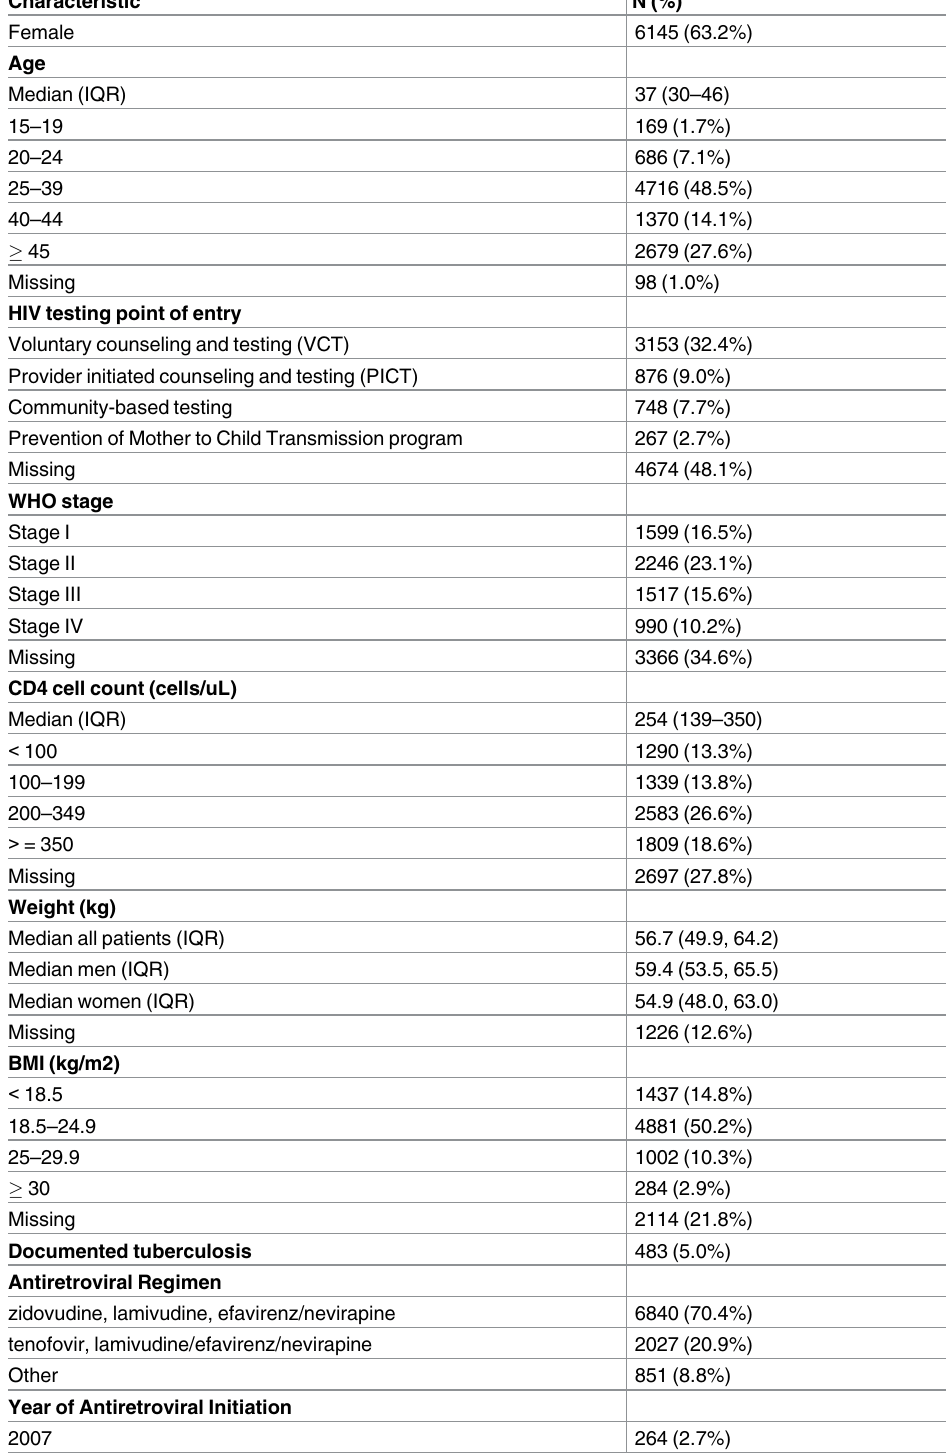
Table 1. Patient and facility characteristics at time of antiretroviral therapy initiation in GHESKIO-sup- ported HIV facilities in Haiti from July 2007-December 2013 (N =